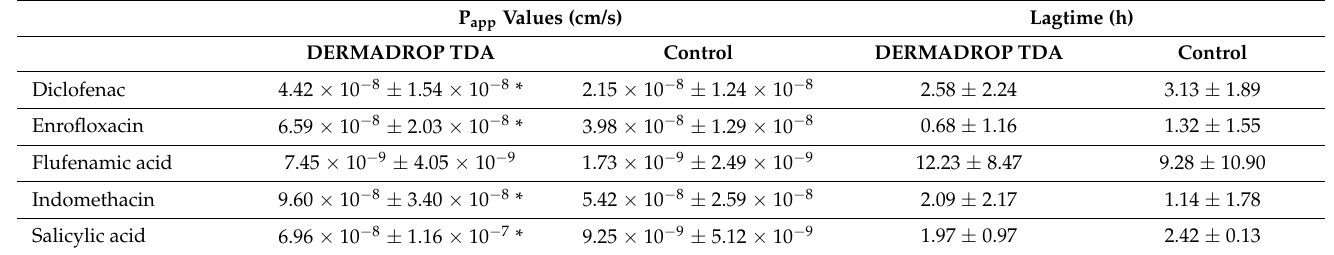
Table 2. P app values and lagtimes of the different drugs applied via DERMADROP TDA and via pipette (control). Asterisks (*) indicate p < 0.05 (Mann–Whitney Test). P app Values (cm/s) Lagtime (h) DERMADROP TDA Control DERMADROP TDA Control